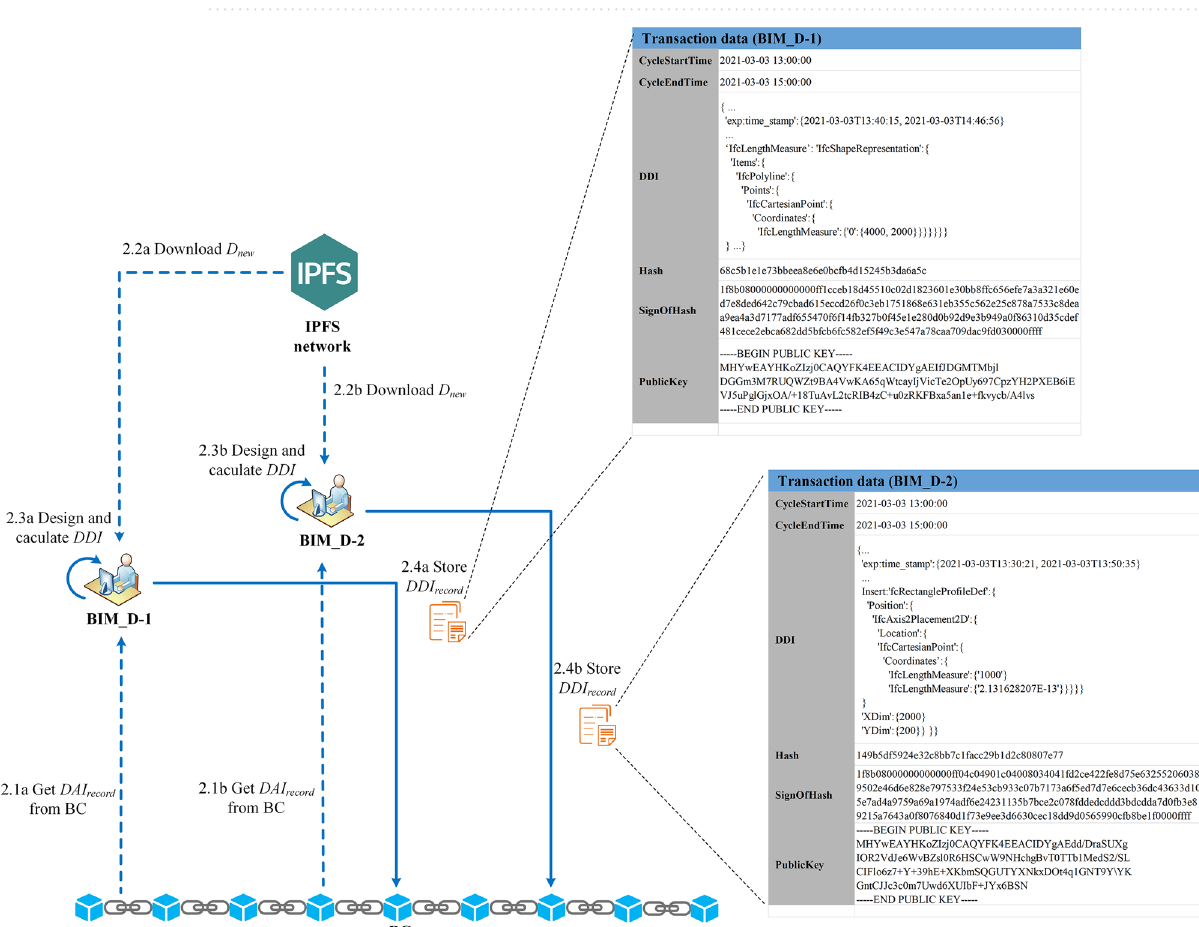
Figure 18. Example: BIM_D design BIM